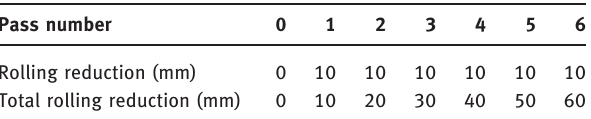
Table 3: Rolling schedules.